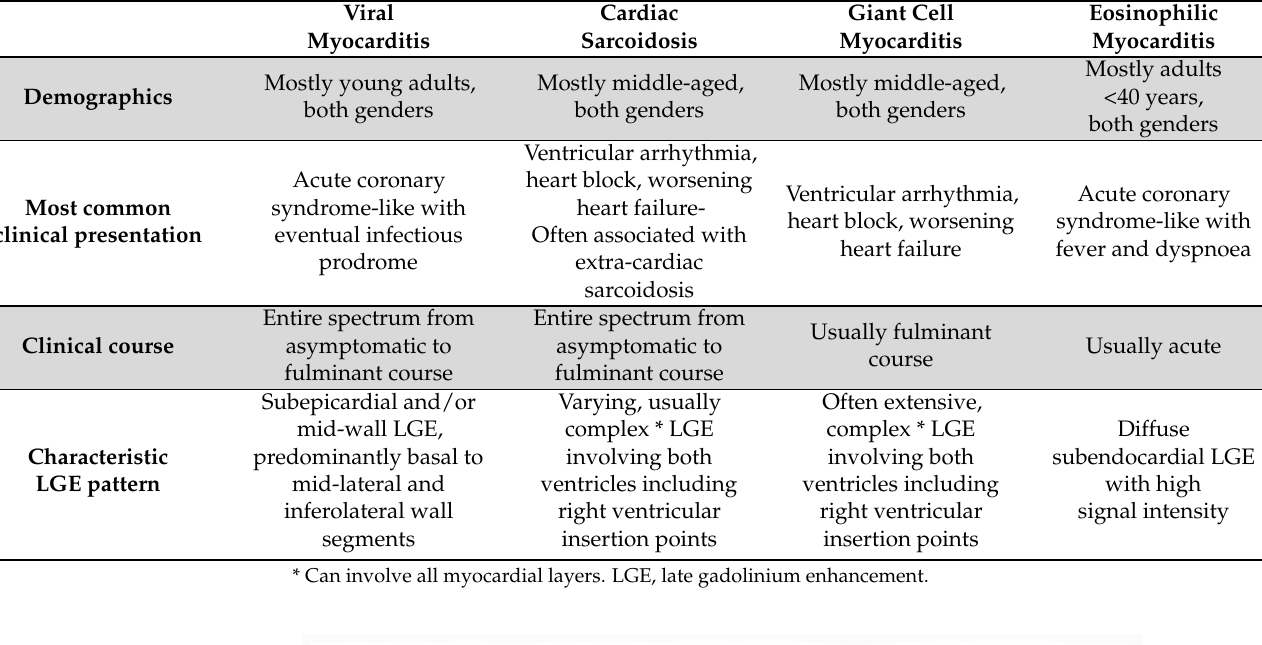
suspected myocarditis [87–89]. However, only in a few cases histological evidence of lym- phocytic infiltration or the presence of the SARS-CoV-2 genome could be found [90,91]. Based on the current available evidence, viral myocarditis seems to be rare in patients with COVID-19, and the underlying pathomechanism is still somewhat unclear. Myocarditis following mRNA COVID-19 vaccination is a rare complication in pre- dominately male adolescent and young adults, usually of mild nature [92,93]. In these cases, CMR usually shows classic signs of myocarditis as in viral myocarditis [94]. Still, the long-term outcome of vaccine-related myocarditis remains to be clarified. 5.3. Giant Cell Myocarditis GCM is a rare, often rapidly progressive disease, which usually affects middle-aged adults and carries a high mortality if untreated [95]. The diagnosis of GCM remains chal- lenging and relies mainly on EMB to establish the final diagnosis. CMR often shows signs of extensive inflammation with widespread LGE involving all myocardial layers as well